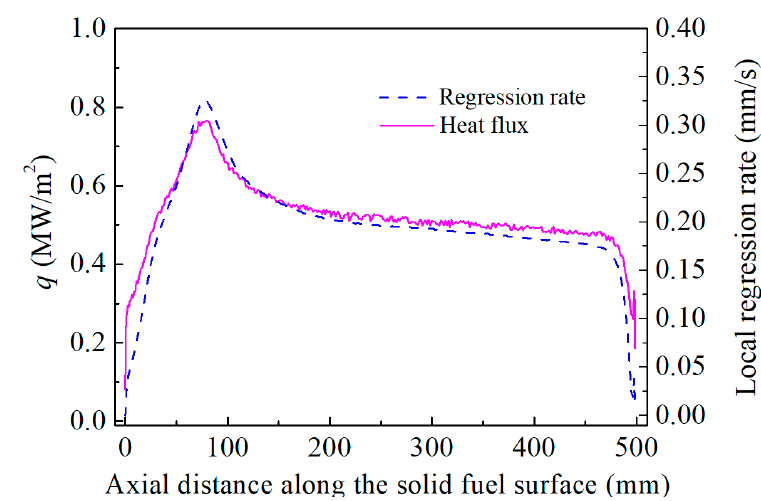
Figure 20. The local regression rate of different time.